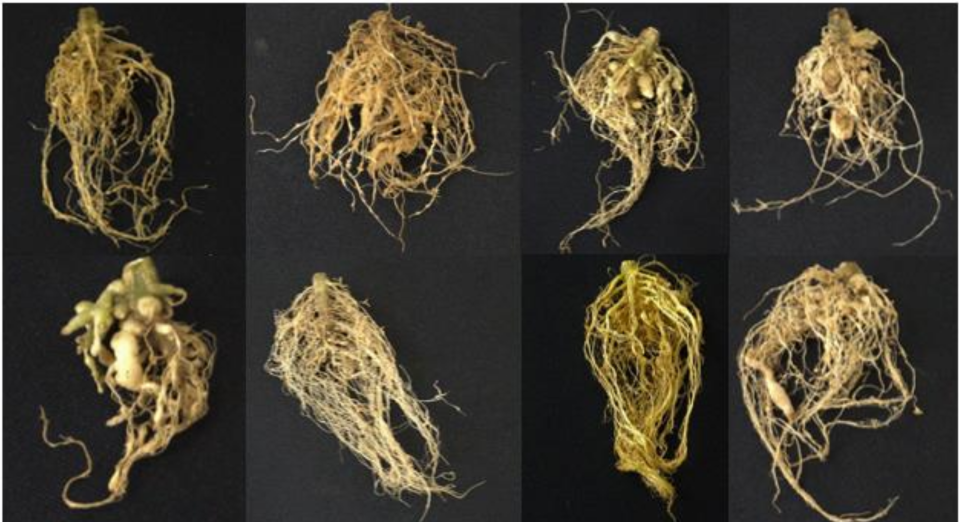
Figure 1. Disease reactions in the roots of tomato varieties infected with Meloidogyne incognita . Top (from left to right): Diamante Max F1, Ilocos Red, Avatar TY F1 and Athena; Bottom (from left to right): Rica, Tm 2016 11-1 Cherry, 2018-54 Cherry Tm LTB and Rosanna (the susceptible